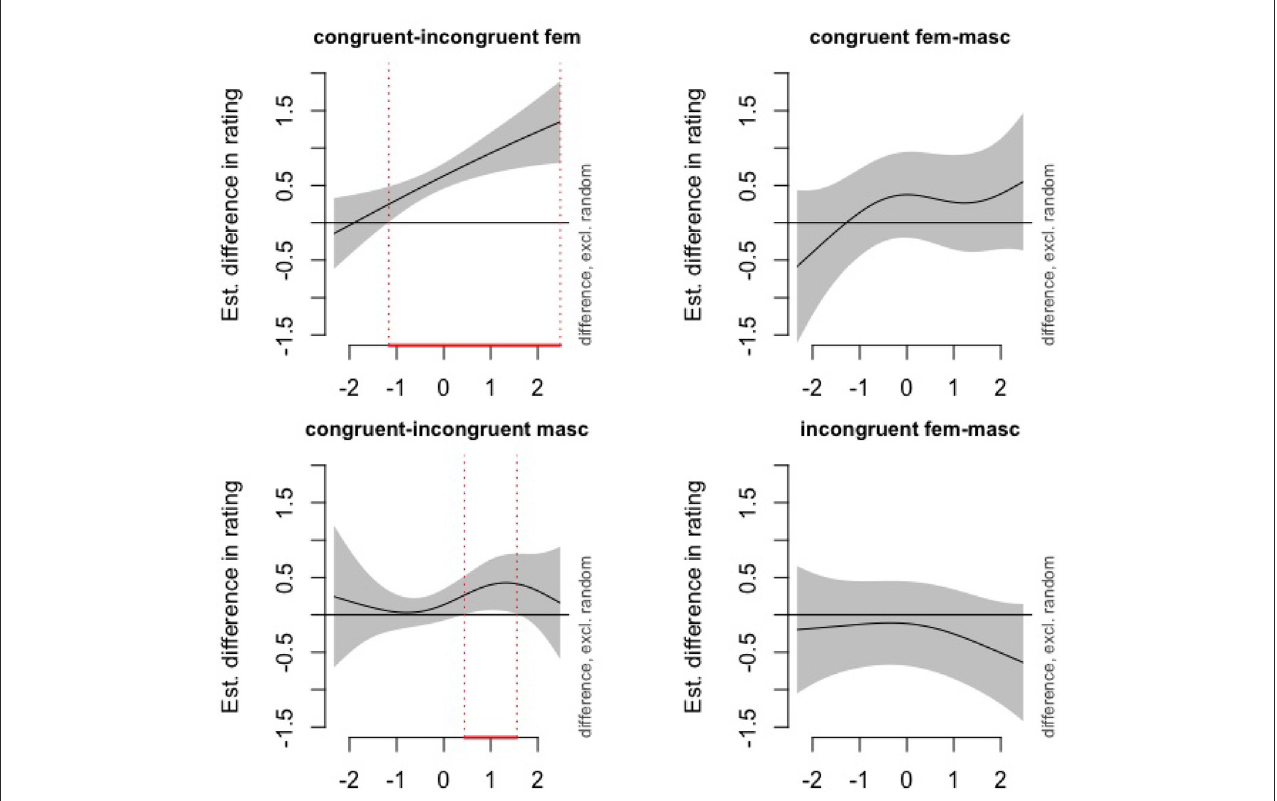
FIGURE1 Openness: Difference plots depicting the interaction between openness and stereotype congruence. More negative/positive values on the x-axis indicate lower/higher openness. (Upper left) Congruent minus incongruent female stereotyped role name; (Upper right) congruent female minus congruent male stereotyped role name; (Lower left) congruent minus incongruent male stereotyped role name; (Lower right) congruent female minus incongruent female stereotyped role name. Vertical, red, dotted lines indicate the area of significant